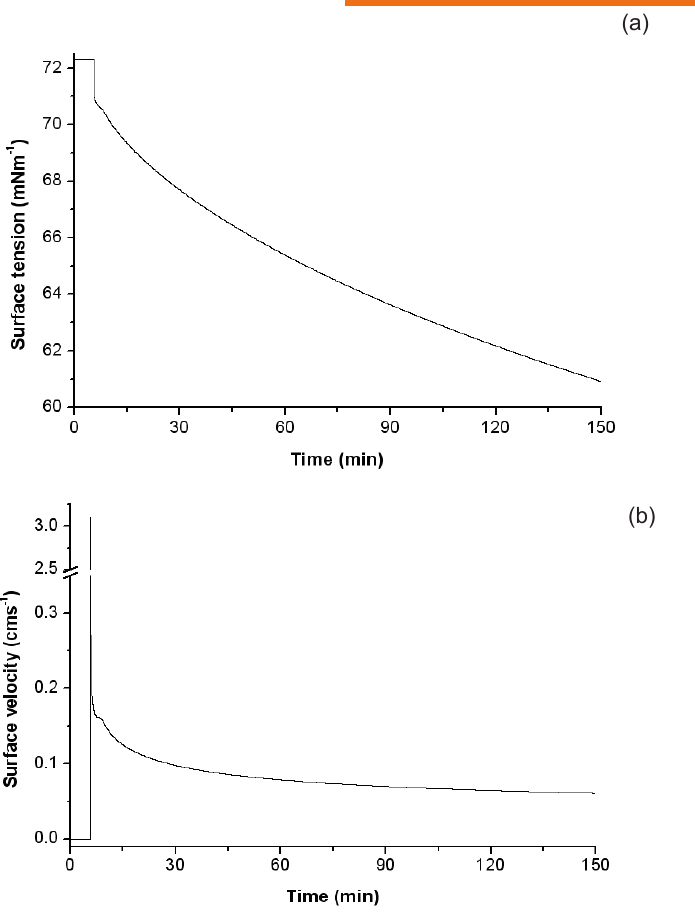
Figure 9. Results of numerical simulation on dissolution of a hexanol droplet under the air/water interface: vessel diameter d=40 mm, capillary immersion depth h=4 mm, buoyancy is neglected; a) Surface tension vs time, b) surface velocity vs time (reprinted from [43], with permission from American Physical